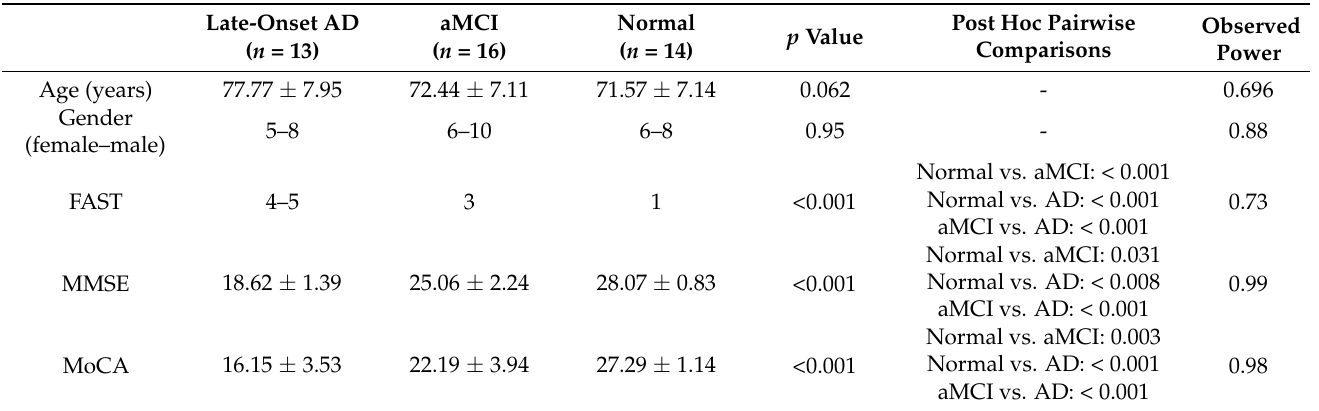
Table 1. Demographic and cognitive